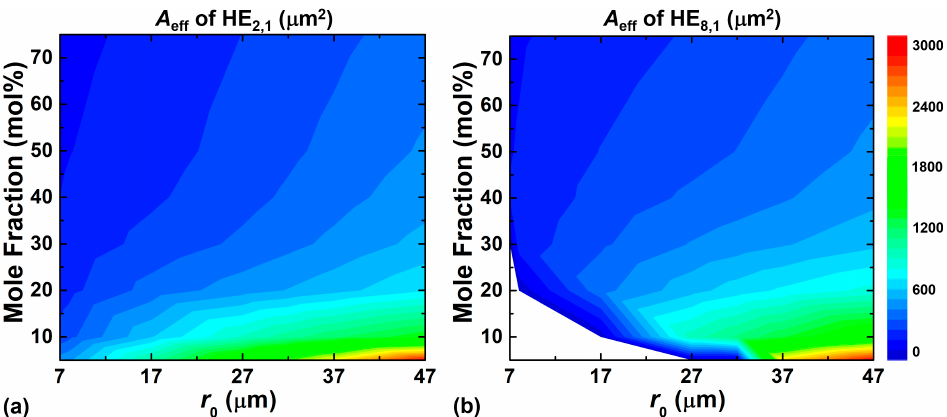
Figure 6. Effective areas of the ( a ) HE 2,1 and ( b ) HE 8,1 modes with α = 2 under different mole fractions of GeO 2 and the position of the